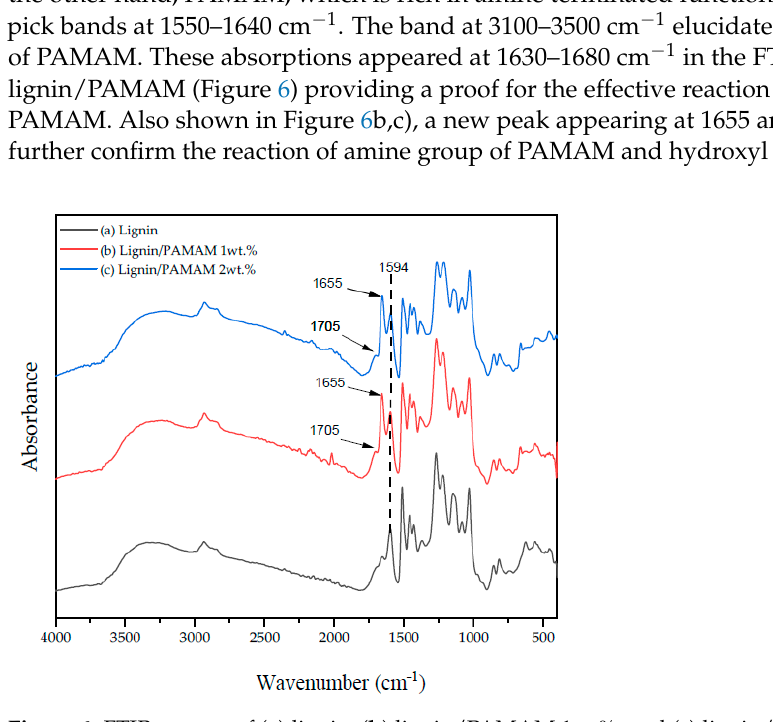
Figure 6. FTIR spectra of ( a ) lignin, ( b ) lignin/PAMAM 1wt%, and ( c ) lignin/PAMAM 2wt%. Table 5. Main chemical elements in lignin samples and their range of evolution, detected by